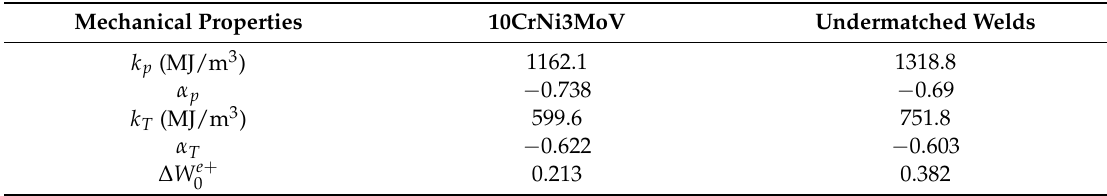
Figure 14. Comparison of total strain energy density ∆ W t from different equations: ( a ) 10CrNi3MoV high strength steel; ( b ) undermatched welds. Table 8. Energy-based properties of 10CrNi3MoV high strength steel and undermatched welds.